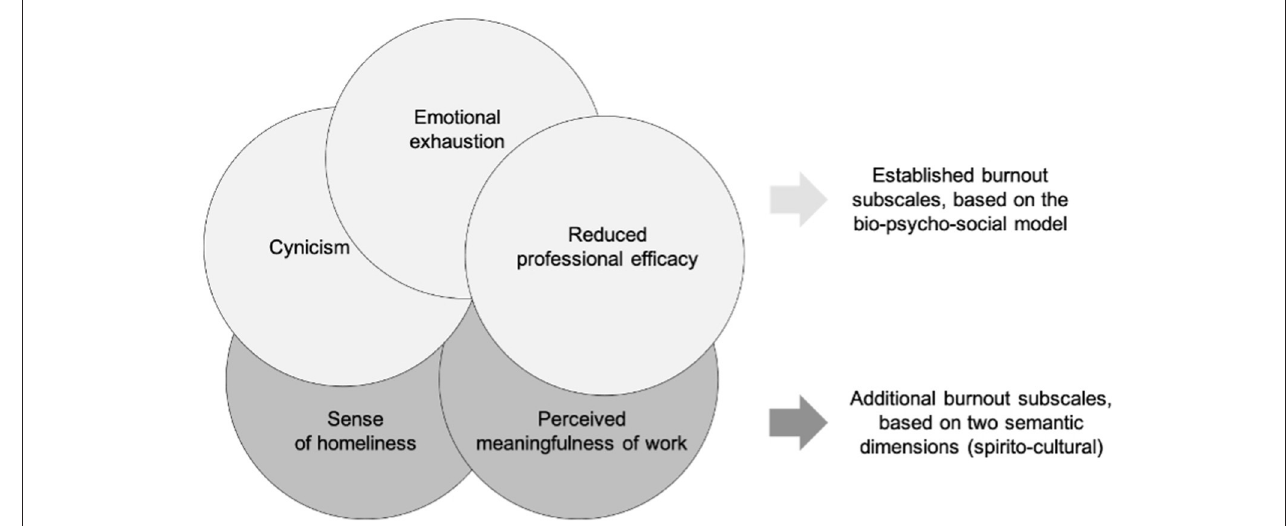
FIGURE 5 | Extended concept of burnout. Own presentation, based on Esch